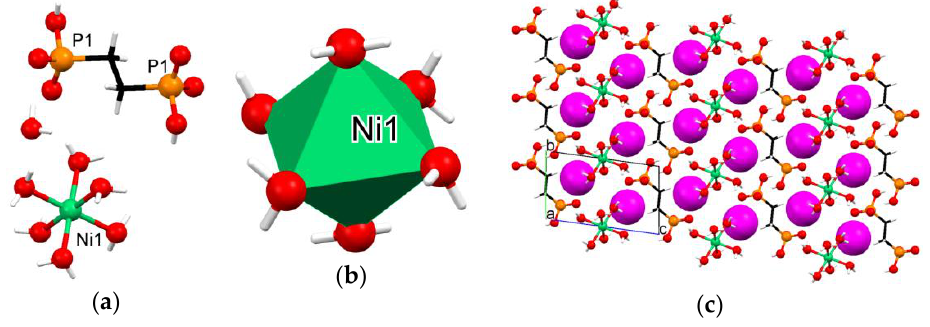
Figure 5. Crystal structure of Ni-EDPA : ( a ) View of the cation-anion pair; ( b ) The [Ni (H 2 O) 6 ] 2+ polyhedron; ( c ) Packing along the a axis. Lattice waters are shown as magenta spheres.